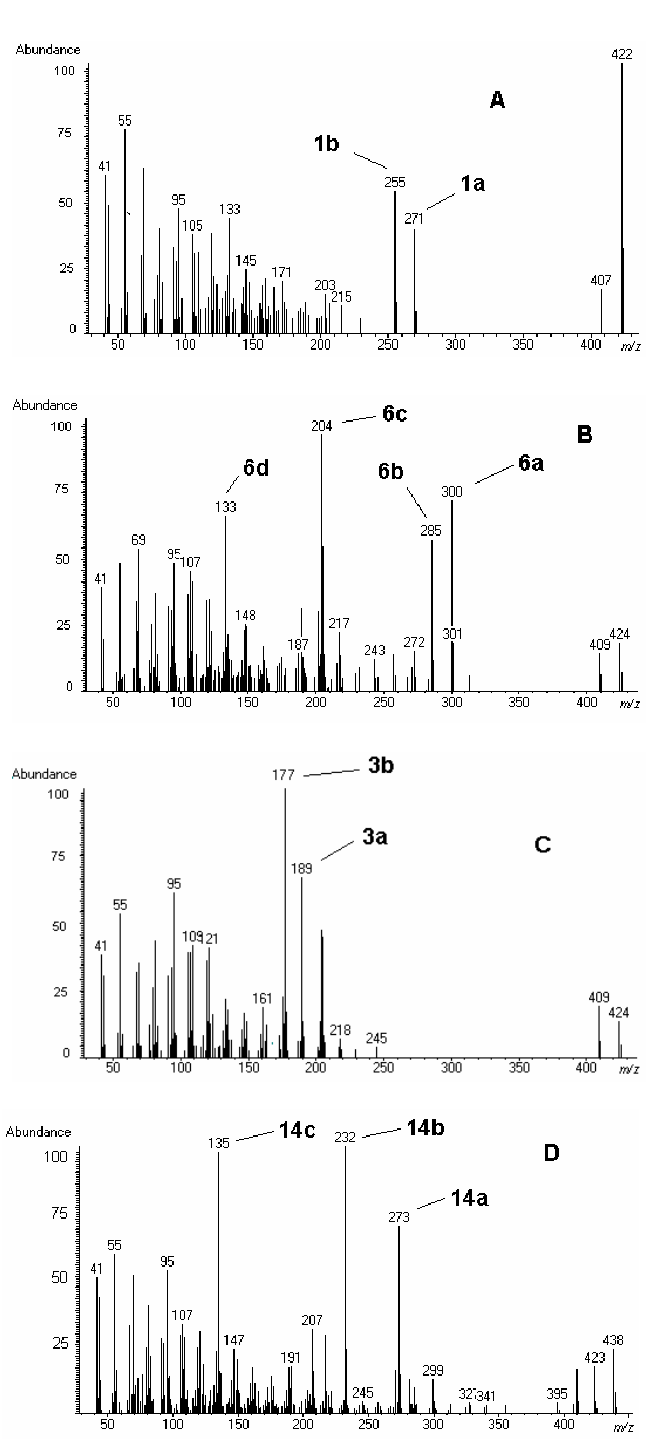
Fig. 2 – Mass spectra of some minor pentacyclic triterpenes: A) 1 , B) 6 , C) 3 and D) 13 . Total Ion Chromatogram: see Figure